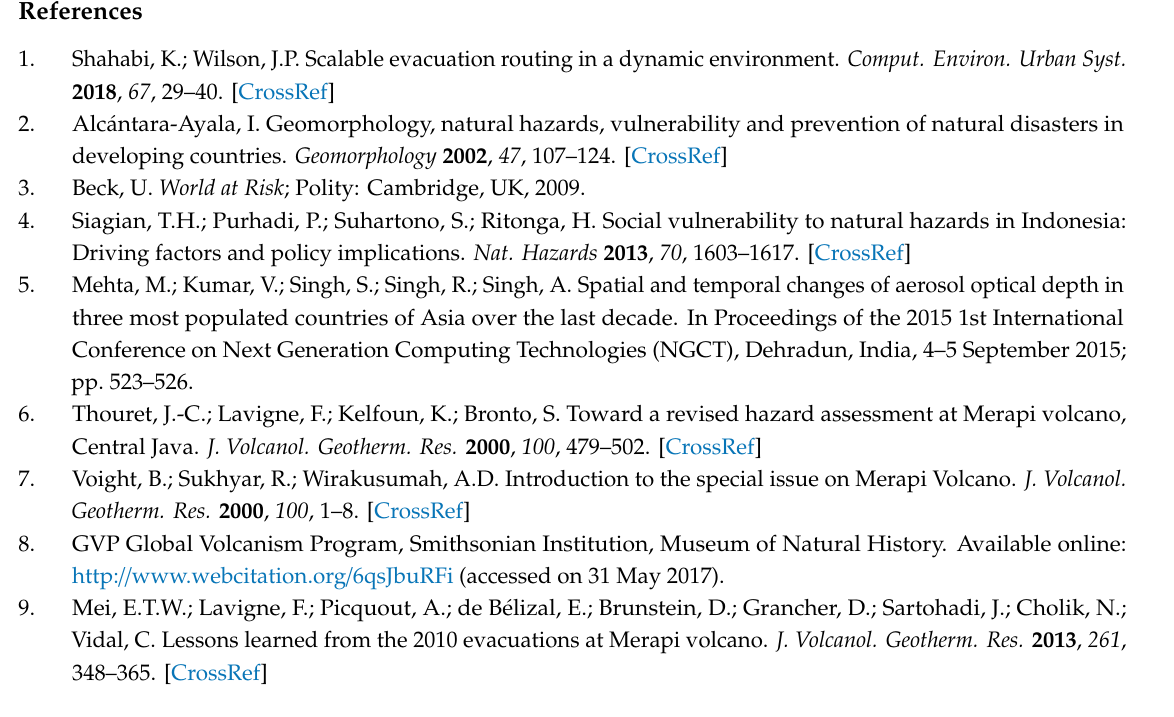
for Table 2 (https: // osf.io / fzhua / ), S3: Data for Table 3 (https: // osf.io / bjfcv / ), S4: Data time interval calculation for Table 4 (https: // osf.io / ef4n3 / ), S5: Source code for simultaneous experiment (https: // osf.io / ef4n3 / ), S6: Source code for staged experiment (https: // osf.io / v3gfd / ), S7: Model description (ODD) (https: // osf.io / s936h / ), S8: